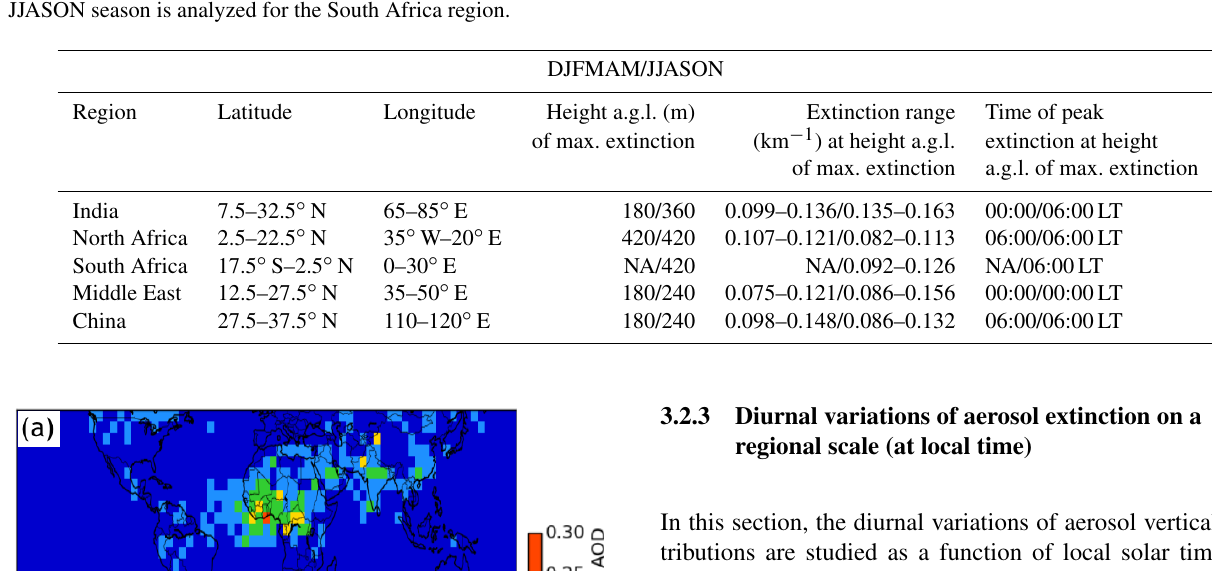
Table 4. Geographic ranges, height above ground level of maximum extinction, diurnal extinction range at height of maximum extinction and time (local) of peak extinction for the boxed red regions in Fig. 6 and vertical profiles shown in Figs. 12 and 13. Note that only the JJASON season is analyzed for the South Africa region.